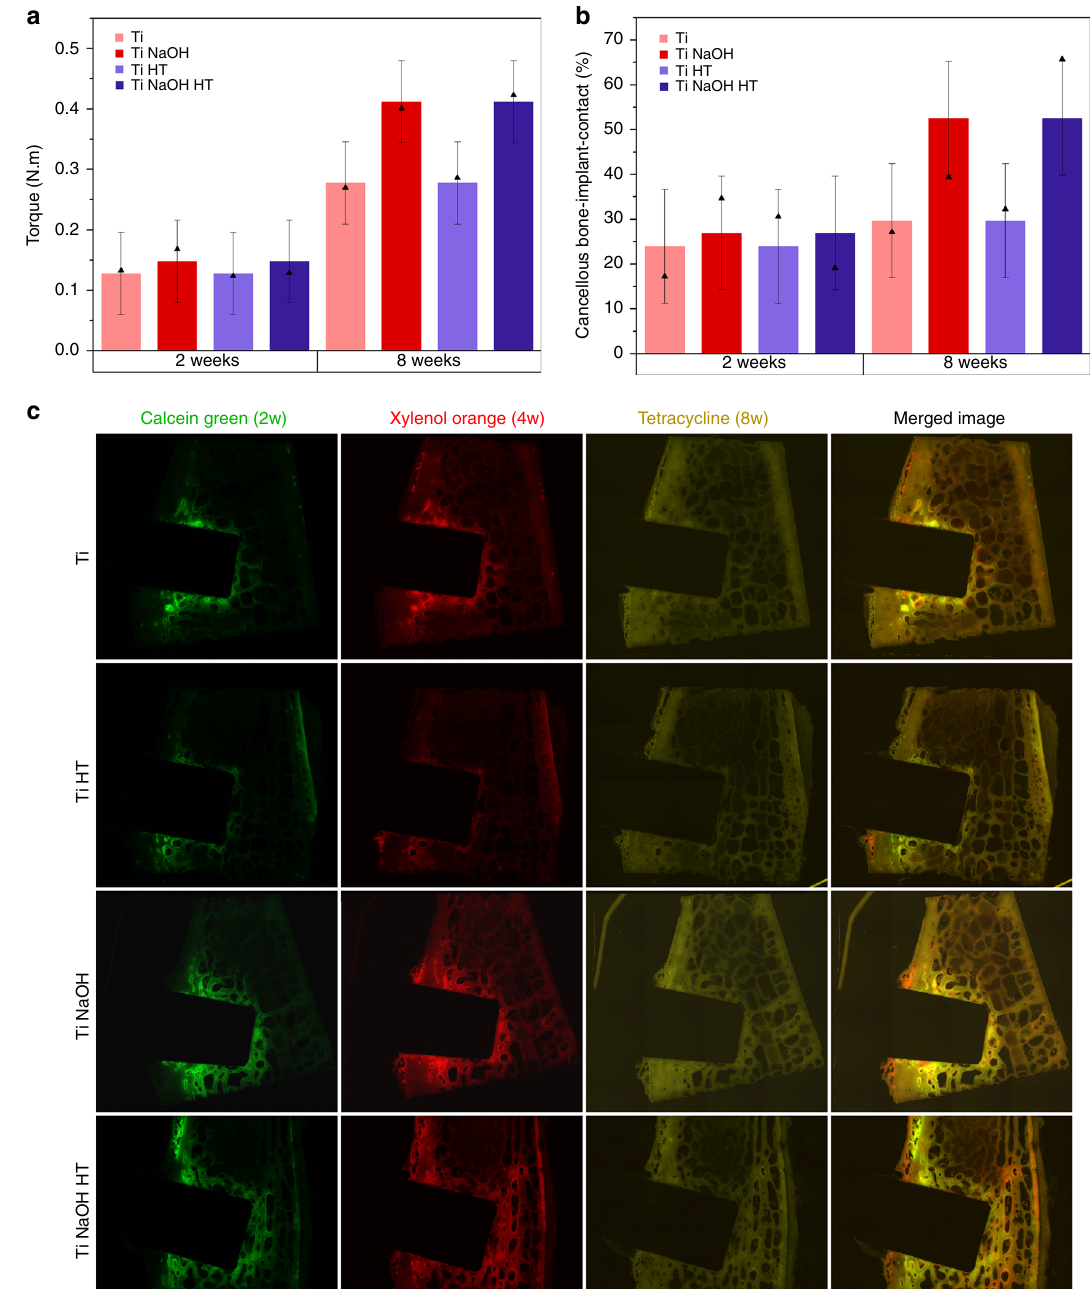
Fig. 6 In vivo response for different Ti surfaces. a Control chart for the yield torque values and b Control chart for the cancellous bone-implant-contact. The columns give the fi tted value according to a multifactorial statistical analysis with error bars corresponding to the 95% con fi dence interval. The solid triangles give the experimental mean values based on six replicates. For both tests, factor NaOH treatment ( p < 0.01), time delay ( p < 0.01), and the interaction of the two factors ( p < 0.05) are identi fi ed to be statistically signi fi cant. Other interactions are treated as noise due to insigni fi cant effect of factor heat treatment, position, and replicate. c Fluorochrome labeling of titanium implants after 2, 4, and 8 weeks for the 8-week group. The visible green regions represent the bone deposition 2 weeks after implantation. Similarly, the red regions represent 4 weeks deposition and yellow region represents bone deposition 48 – 72 h before the sacri fi ce (roughly 8 weeks after implantation). Merged images are provided in the right column. Since six replicates are used for each implant type, the images chosen are not necessarily a quantitative average representative of the bone remodeling process for each implant type. However, the same sheep (#04) is chosen in this case (based on image quality) to lower the inter-animal variability for enhanced